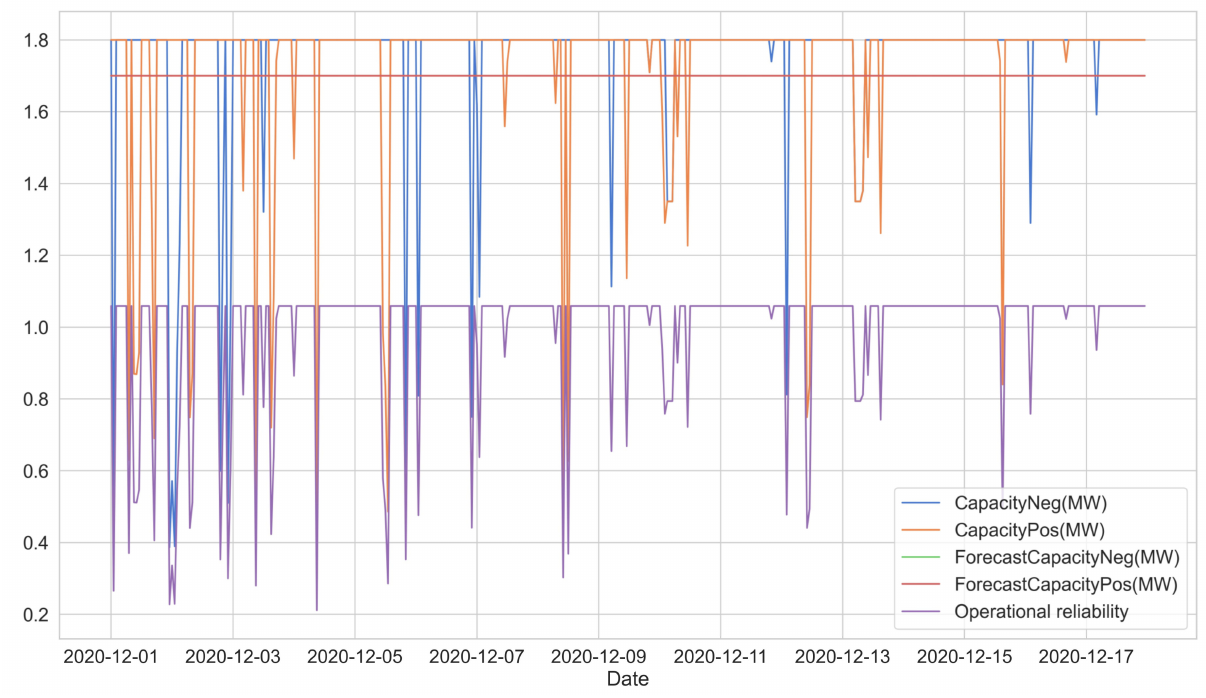
Figure 4. Operational reliability calculation for a battery storage